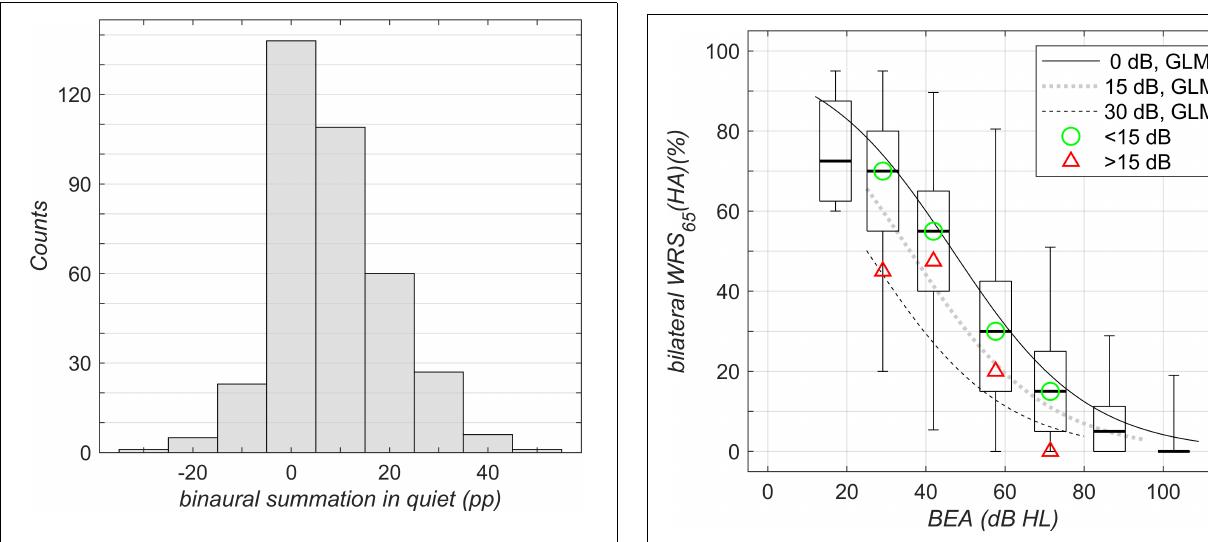
FIGURE 4 | Bilateral aided speech-recognition scores in noise plotted against WHO classification of hearing loss. Boxplots and solid/dotted/dashed lines as in Figure 1A . The green circle and the red triangle denote the median of the data with corresponding WHO grade for asymmetries below and above 15 dB,